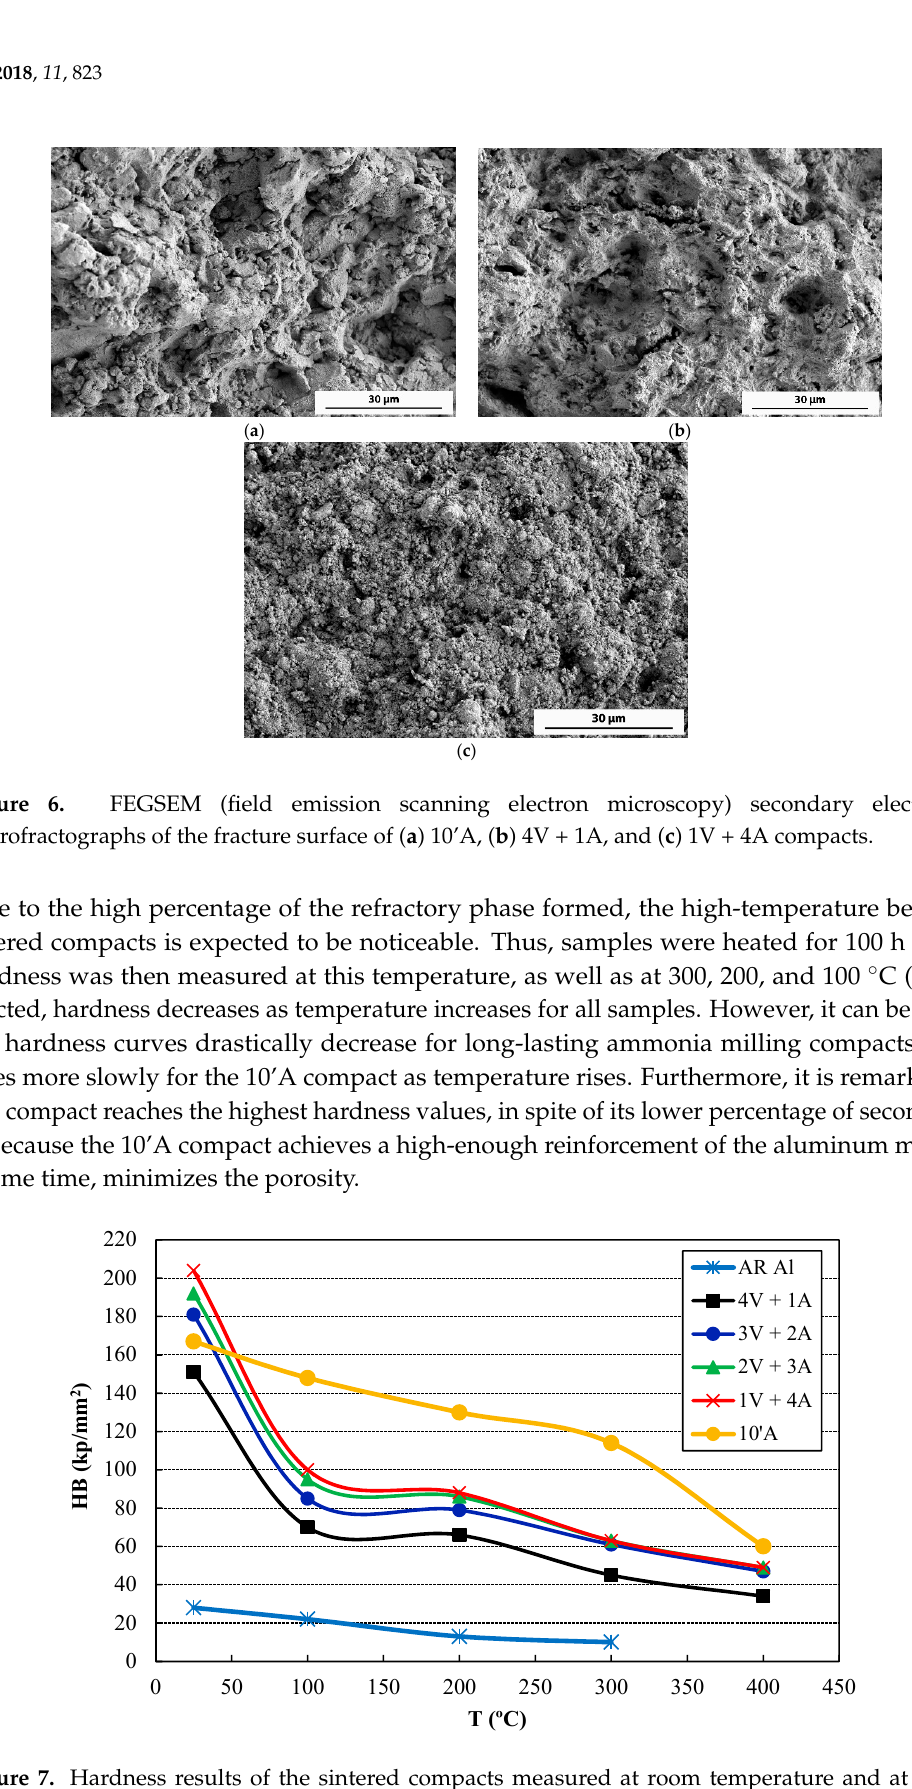
Figure 7. Hardness results of the sintered compacts measured at room temperature and at high temperatures after a heat treatment of 100 h at 400 °C.